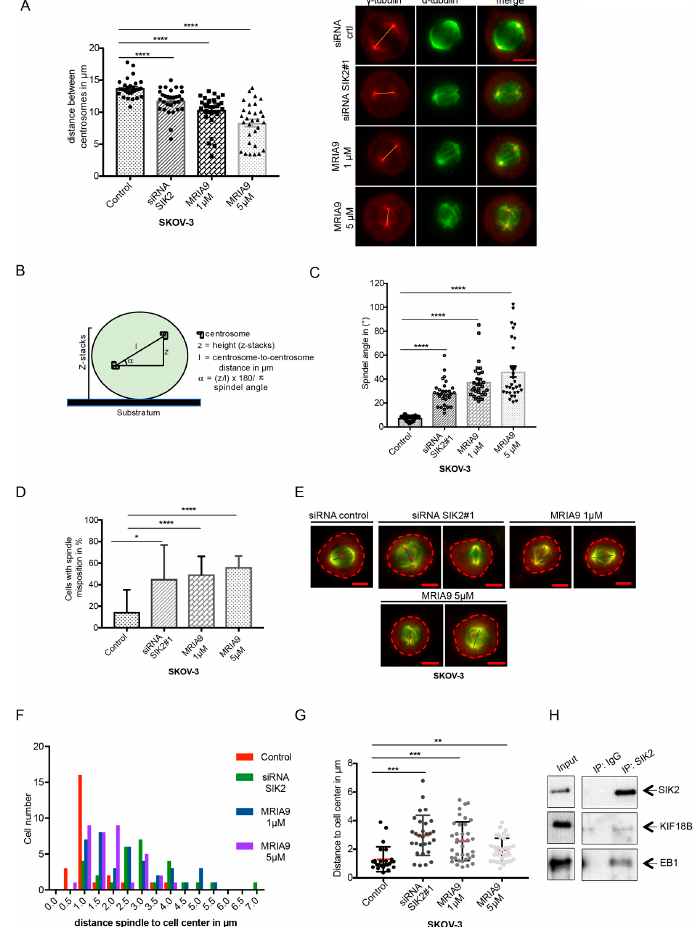
Figure 3. MRIA9-induced inhibition of SIK2 results in spindle position failures in SKOV-3 cells. ( A ) Inhibition of SIK2 using MRIA9 reduces the distance between the spindle poles. SKOV-3 cells were treated with siRNA SIK2#1, with 1 µ M and 5 µ M MRIA9. After 48 h, cells were immunostained with α -tubulin, γ -tubulin, and the pole-to-pole distance of prometa-metaphase cells was measured. (Left) The spindle lengths are presented as mean ± SD and statistically analyzed (**** p < 0.001, n = 30 cells). (Right) Representatives of SKOV-3 with reduced spindle length after depletion or inhibition of SIK2 using MRIA9. Scale bar = 10 µ m. ( B ) Schematic representation of how the spindle axis is measured. The given formula is used to calculate the spindle angle. ( C ) The angles of the spindle axes in SKOV-3 cells treated with siRNA SIK2#1 or 1 µ M and 5 µ M MRIA9 were calculated and represented as mean ± SD and statistically analyzed (**** p < 0.001, n = 30 cells). ( D ) SIK2 depletion or inhibition using MRIA9 causes spindle mispositioning. The percentages of SKOV-3 cells displaying spindle mispositioning upon treatment with siRNA SIK2#1, 1 µ M and 5 µ M MRIA9 are represented as mean ± SD and statistically analyzed (**** p < 0.001, * p < 0.05, n = 30–38 cells). ( E ) Representatives of spindle position in control, siRNA SIK2#1, 1 µ M MRIA9, and 5 µ M MRIA9 treated cells. The cell edges are outlined, and the cell center is represented with a red dot. The blue line indicates the centrosome-to-centrosome distance. Scale bar = 10 µ m. The spindle position of prometa-metaphase cells was evaluated by measuring the distance between the cell centroid and the center of the spindle (midpoint between the two centrosomes). ( F ) Histogram showing the offset distances assessed in the different treatment groups. ( G ) The distribution of the distances between cell center and spindle midpoint is represented as a scatter plot. The results were statistically analyzed (*** p < 0.001, ** p < 0.01, n = 25–38 cells). ( H ) The interaction between SIK2, EB1, and KIF18B was investigated in SKOV-3 cells by co-immunoprecipitation using SIK2 specific antibodies. The precipitates and 5% of the input were subjected to immunoblotting using the indicated